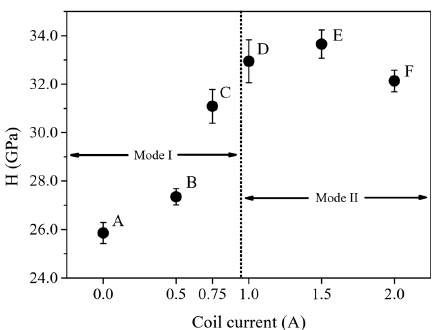
Figure 11. Hardness of coating as a function of coil current. Letters (A–F) indicate sample labeling (see Table 1).